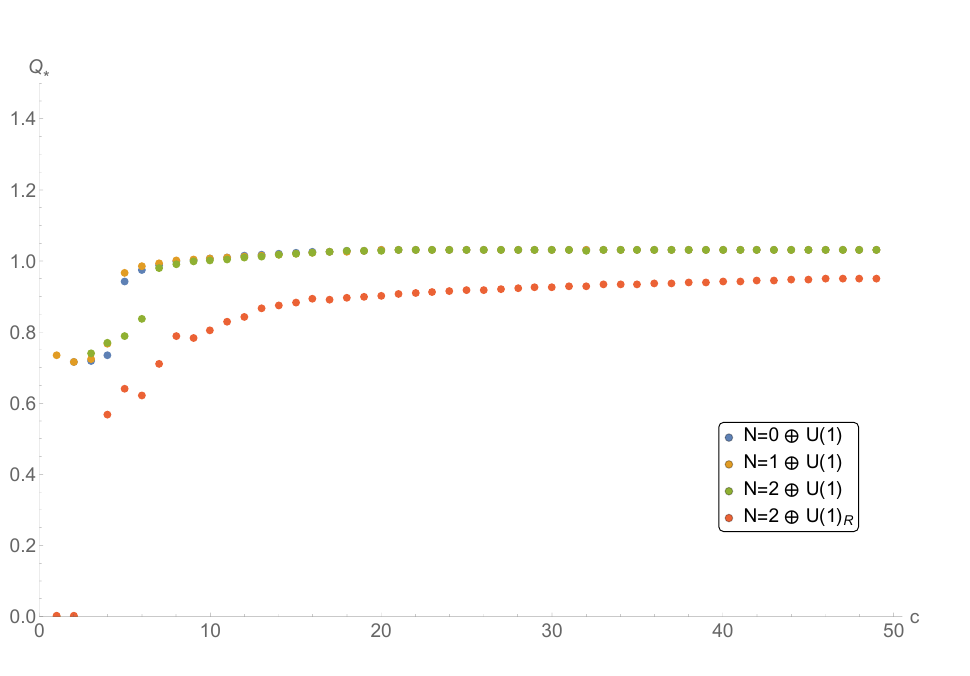
Figure 14 . Upper bounds on the lowest charge. There must be at least one charged state with the charge lower than the bound. The level of U(1) current was normalized by 1. Notice that the three cases for the non-R U(1) charge bounds almost